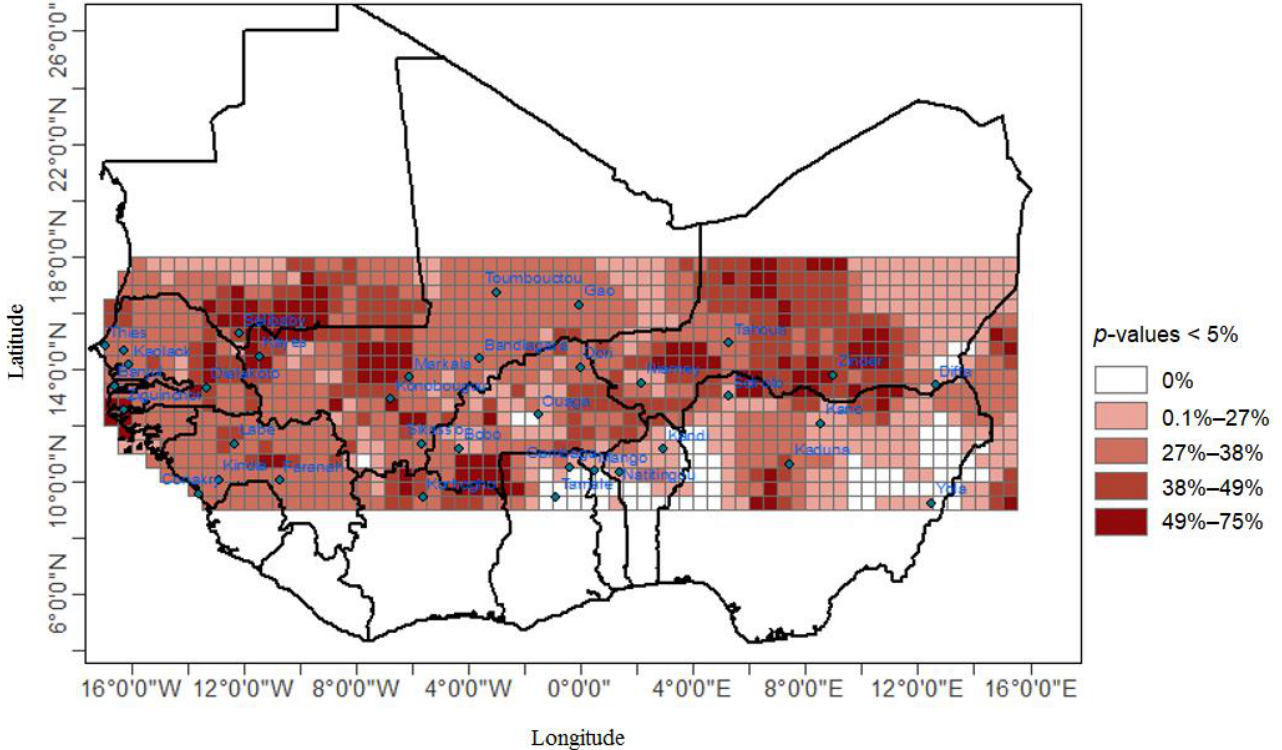
Figure 5. Proportion of p -values lower than 5% for the CRU_2012 data with segments of 30 years.